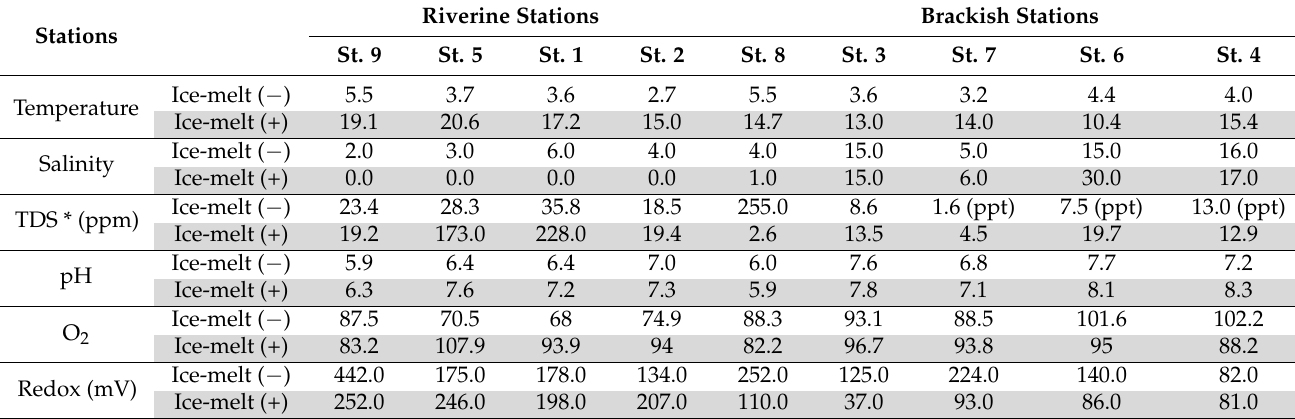
Table 1. Physical-chemical parameters of water samples measured in Ice-melt ( − ) (May) and Ice-melt (+) (July) seasons. Riverine Stations Stations